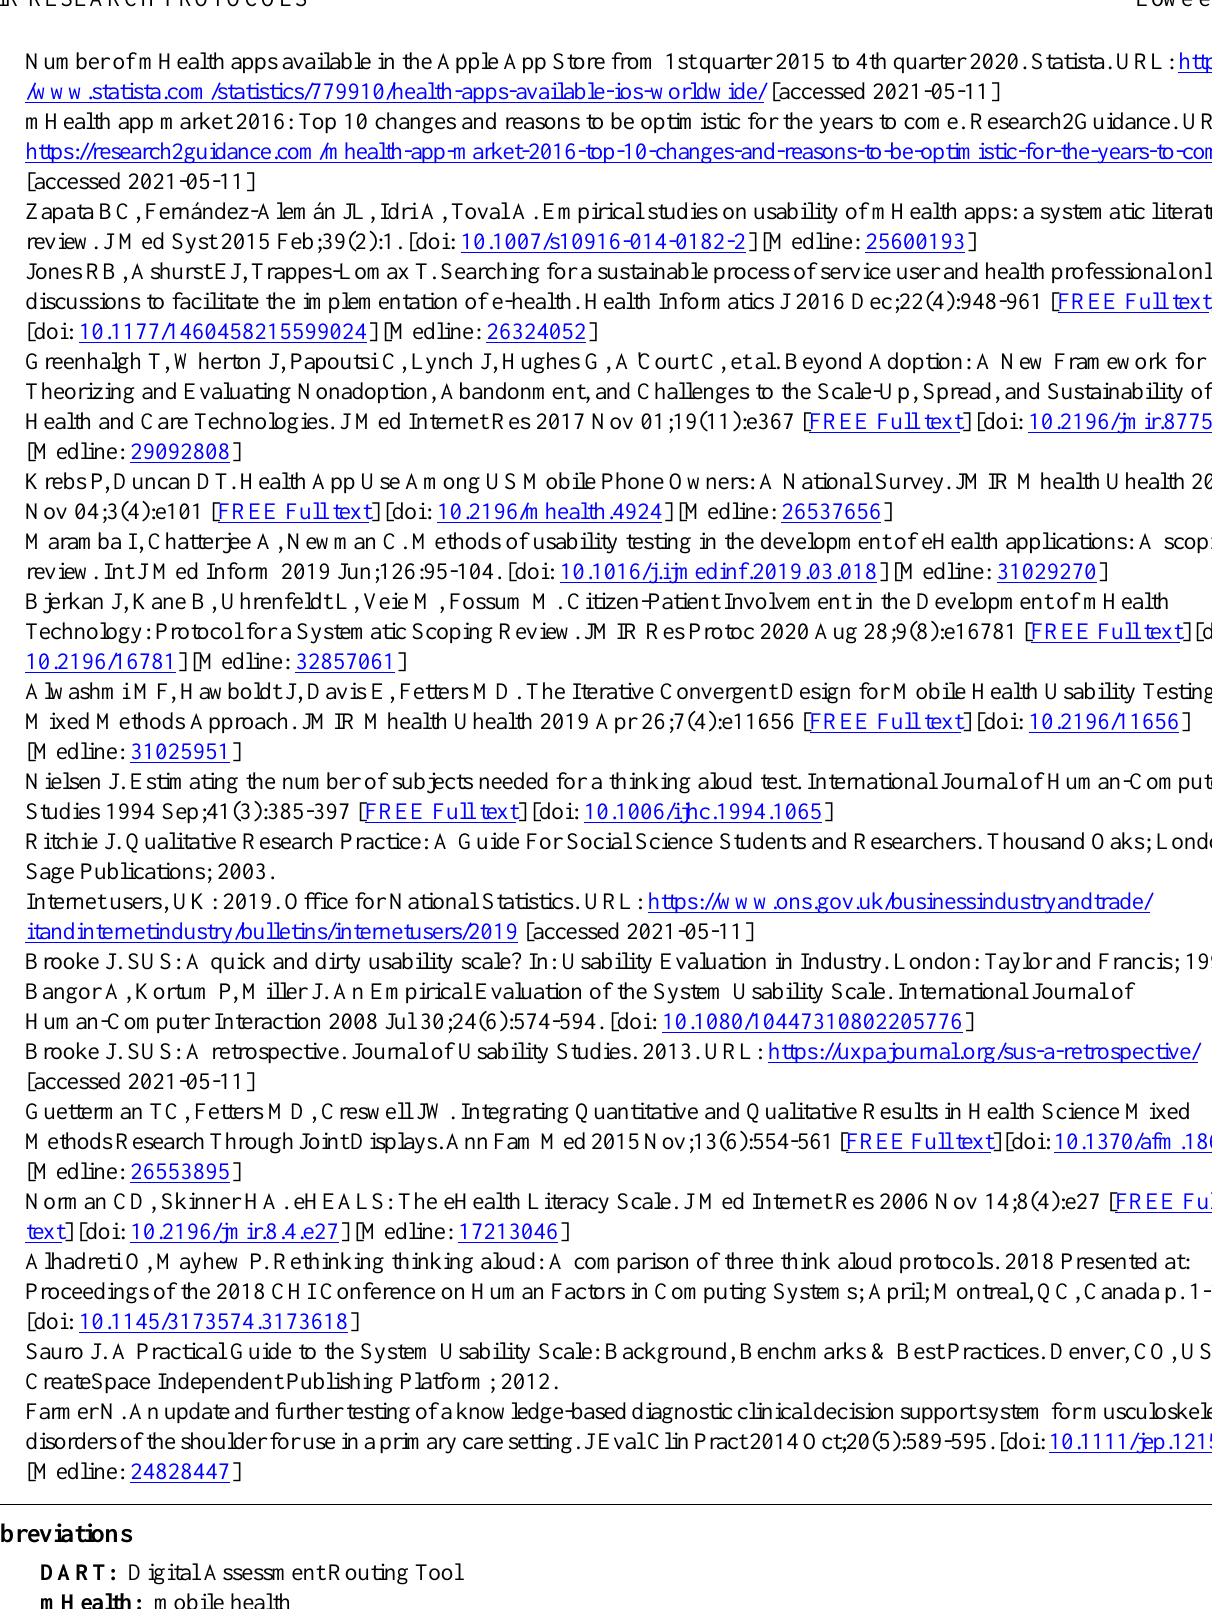
DART: Digital Assessment Routing